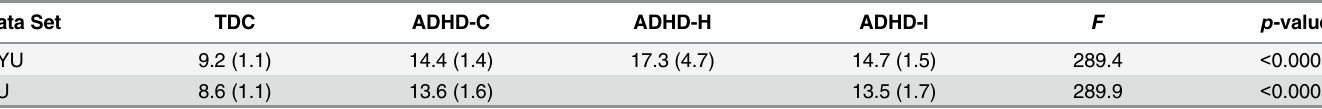
Table 3. Group means and standard deviations of the filter function value for TDC and three ADHD subtype